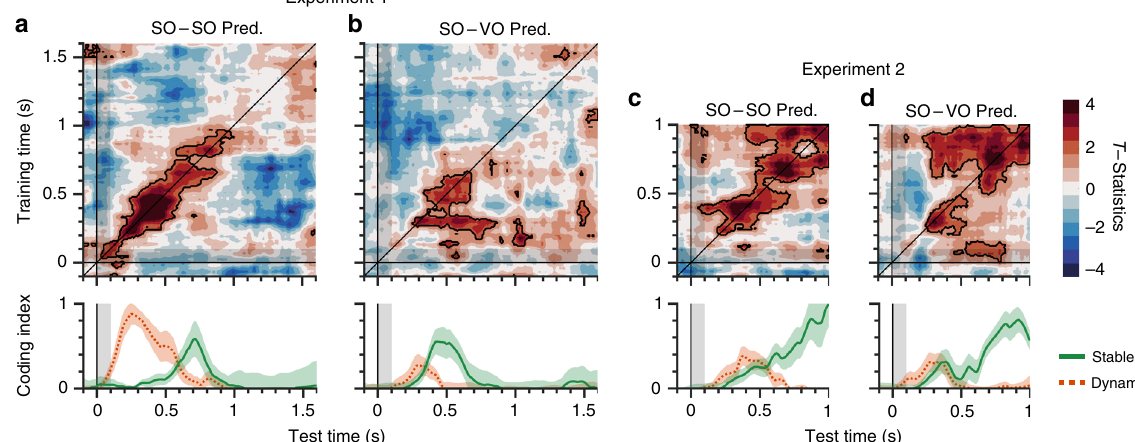
Fig. 4 Temporal generalization (TG) methods showed distinct temporal coding, summarized by a stable/dynamic index. First, the EEG signals at time 0 were used to train the SO decoder. This SO decoder was generalized to EEG signals over a whole period. This was repeated until the EEG signals at the fi nal time was used to train the SO decoder. a SO – SO temporal generalization in Experiment 1 showed earlier dynamic coding and later stable coding, neither of which were persistent over time. b SO – VO temporal generalization results from Experiment 1. c SO – SO temporal generalization results from Experiment 2. d SO – VO temporal generalization results in Experiment 2. Top, the x - and y-axes show the time of test and training sets after stimulus onset, respectively. Colors represent the t -statistics. Black areas show signi fi cant modulation over time, determined by a one-sided Monte Carlo randomization test, p < 0.05. Bottom, a stable/dynamic index summarized their temporal coding. The x -axis shows the time after stimulus onset. The y -axis shows the magnitude of stable and dynamic coding. Green lines show the stable coding. Red dotted lines show the dynamic coding. Shaded areas represent ± 1 bootstrapped standard error. SO same orientation, VO varied